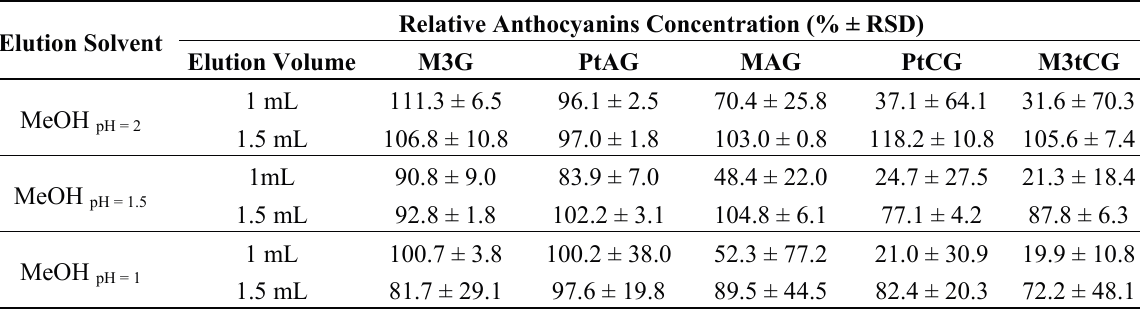
Table 3. Effect of eluting solvent volume and pH on the recovery of anthocyanins ( n = 3). Elution